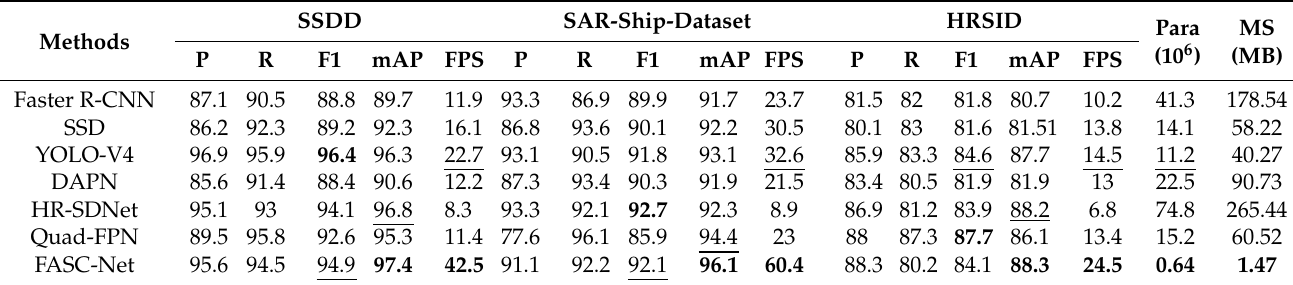
Figure 20. The F1–Confidence curve and P–R curve. ( a ) F1–Confidence curve. ( b ) P–R curve. Table 6. The experimental results and number of parameters of different methods (the best is bold and the second-best is underlined). Para represents the number of parameters, and MS represents model